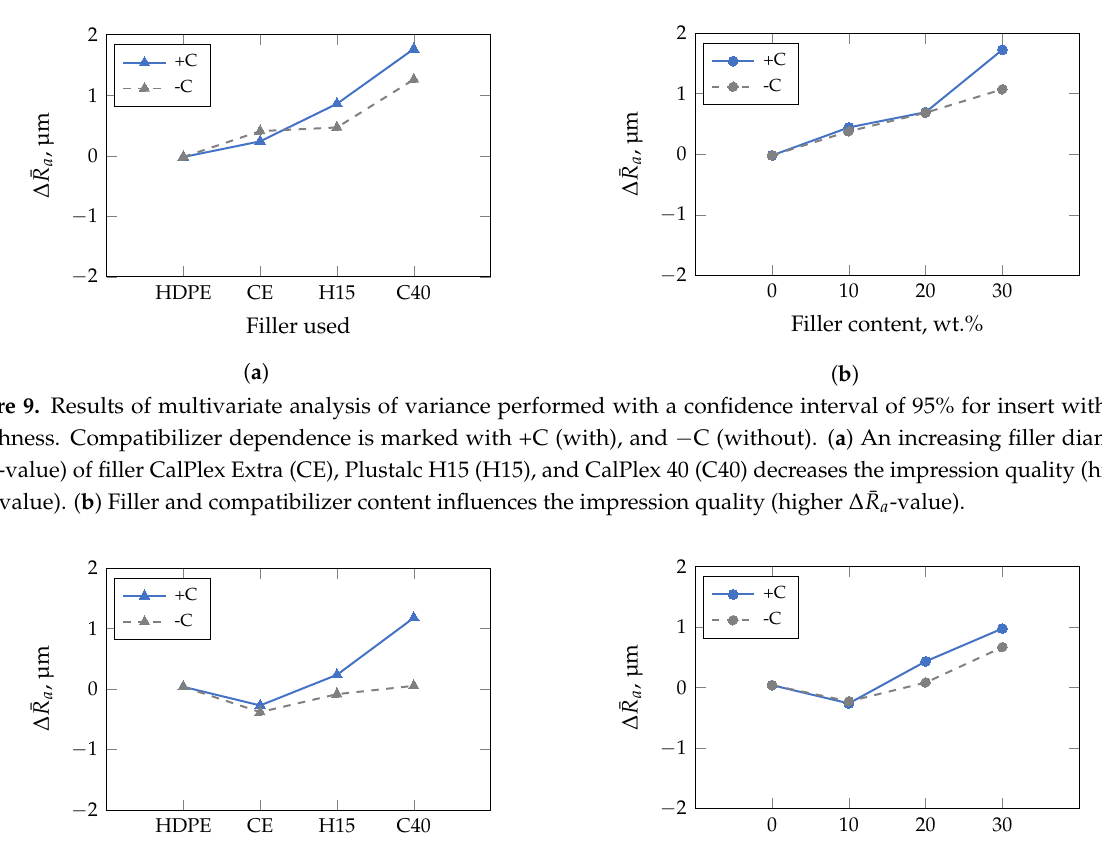
Figure 10. Results of multivariate analysis of variance performed with a confidence interval of 95% for insert with medium roughness. Compatibilizer dependence is marked with +C (with) and − C (without). ( a ) Combatibilizer increases ∆ ¯ R a stronger in comparison to the filler used. CalPlex Extra (CE), Plustalc H15 (H15), and CalPlex 40 (C40). ( b ) Linear dependence of filler and compatibilizer content on impression